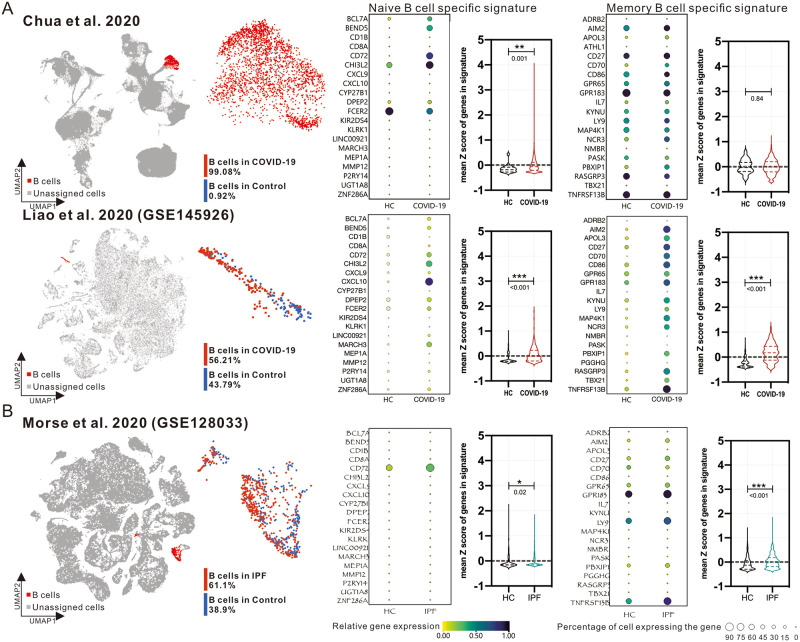
Validation of the phenotypes of B-cell populations in single-cell RNA sequencing of lung-associated body fluid samples from COVID-19 and IPF patients.UMAP shows the visualized distribution of whole cells in single-cell RNA sequencing data from two COVID-19 databases (A) and IPF database (B). the “B-cell clusters” annotated by the original authors are shown in red, the unassigned cells are shown in gray. B-cell clusters are further colored red and blue to represent those from disease or healthy donors (HC) respectively. The proportion and average expression of genes related to Naive or Memory B cells in the B-cell population are shown as dot plots. Relative gene expression is shown in color and the overall B-cell expression gene percentage is shown in dot size (%). The mean Z scores of all genes’ expression in B cell populations from HC or disease groups are shown in Violin plot. Statistical significance was performed using Welch’s t-test approach. *: P < 0.05, **: P < 0.01, ***: P < 0.001. The actual P-values are shown under the asterisks as well.